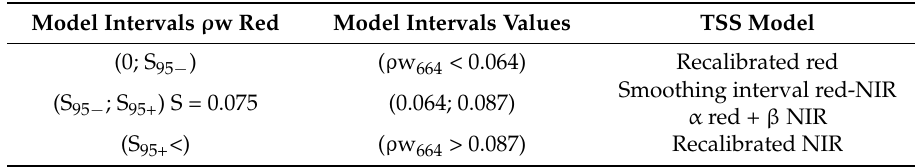
Figure 6. Scatter plot between water reflectance ( ρ w) in the red (664 nm) and near-infrared (NIR, 865 nm) bands extracted for four images on 8 March, 27 May, and 6 and 16 June 2016 in the Guadalquivir estuary and Cadiz Bay Region of Interest (ROI) (Figure 1). The solid black line corresponds to the logarithmic regression fit. The 95% confidence intervals for the regression are represented as red lines. The switching point S is indicated at the intersection of the tangent (blue dashed line) with the y axis. Table 4. Radiometric switching bounds (S 95 − and S 95+ ) used to select the most appropriate Total Suspended Solids (TSS) model based on the water reflectance value in the red ( ρ w 664 ) and near-infrared (NIR, ρ w 865 ) bands.